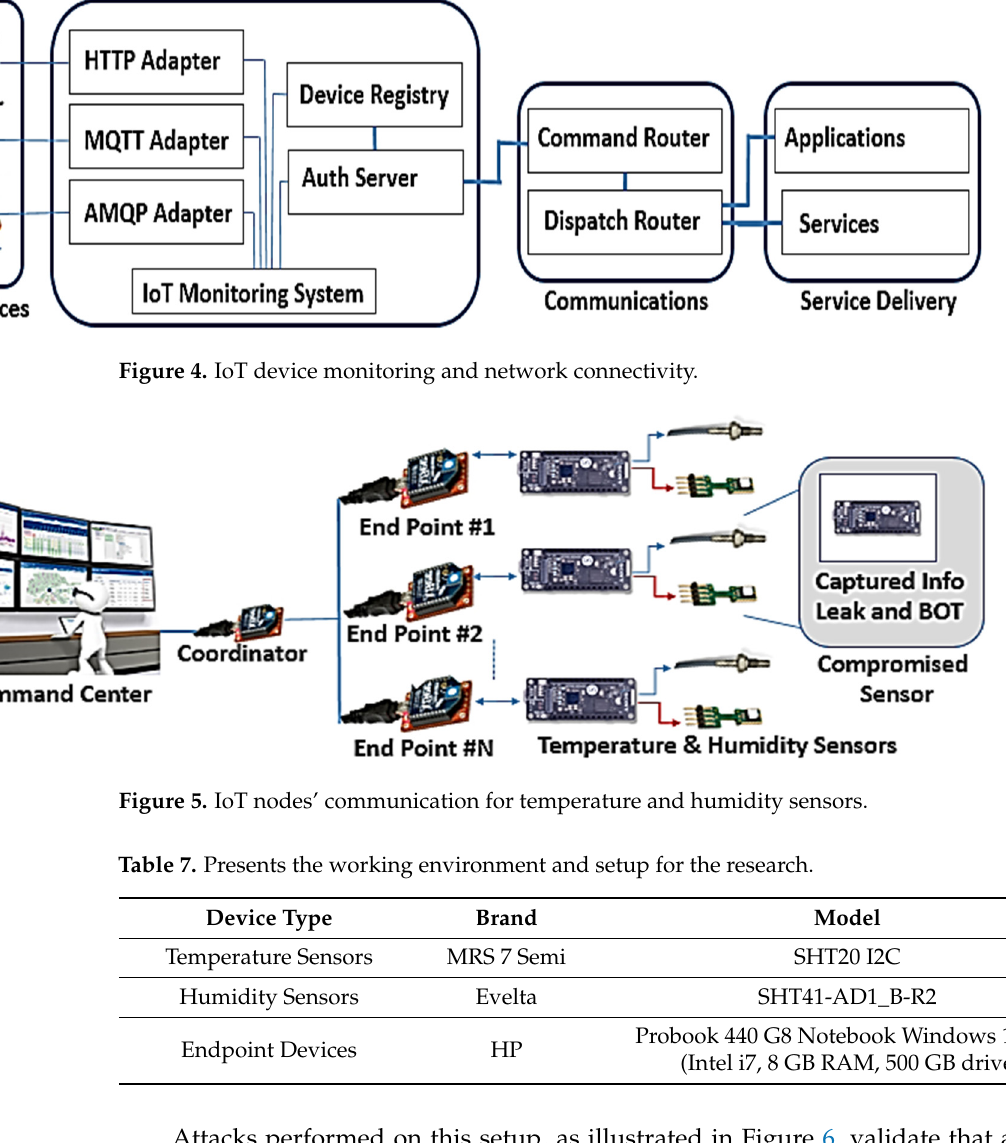
Figure 5. IoT nodes’ communication for temperature and humidity sensors. Table 7. presents the working environment and setup for the research.